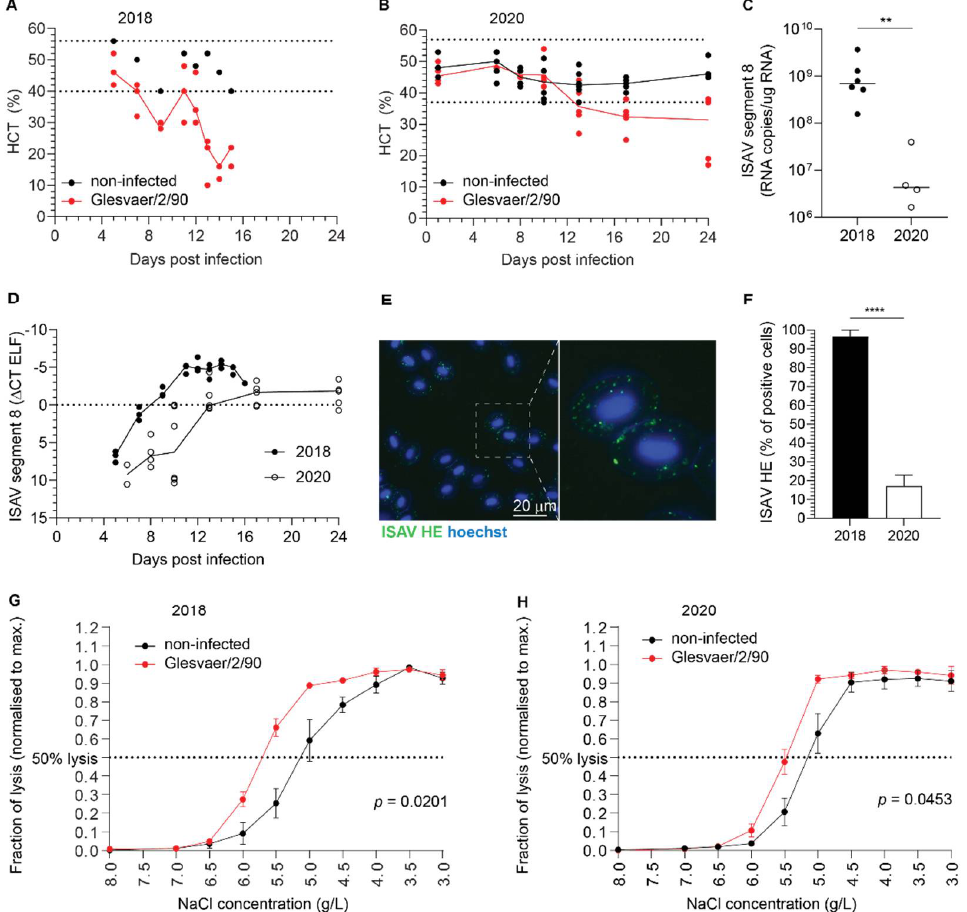
Figure 3. ISAV coats erythrocytes in experimentally infected Atlantic salmon. ( A , B ) A reduction in haematocrit was observed in both the 2018 ( A ) and 2020 ( B ) trials. Dots represent individual fish, solid lines connect median values, and dotted lines indicate the range of values in the non-infected fish group. ( C ) ISAV segment 8 qPCR in blood sampled at the peak of viraemia (12 + 13 d.p.i and 13 d.p.i., respectively) in the 2018 and 2020 trials. Dots represent individual fish, bars show median values. ** p = 0.0095, Mann–Whitney U. ( D ) Viral infection dynamics in full blood in the 2018 and 2020 trials. Dots represent individual fish, lines connect median values. ( E ) Wide-field micrograph of typical appearance of immunostaining for ISAV HE (green) in blood smear from infected fish (here: 5 d.p.i., 2018 trial). Nuclei are shown in blue. Image signal was enhanced in ImageJ [29] (version 2.1.0/1.53c; Java 1.8.0_172 [64-bit]) using the multiply function (process > maths > multiply). ( F ) The percentage of HE-positive erythrocytes at the peak of viraemia in both trials. Bars show median +/ − 95% confidence intervals of manual counts from 10 microscope fields. **** p < 0.0001, Mann–Whitney U. ( G , H ) Osmotic fragility of erythrocytes in the infection trials. The graphs show mean harvested at 9 d.p.i (2018) or 13 d.p.i. (2020), compared to 8 (2018) or 5 (2020) non-infected controls.